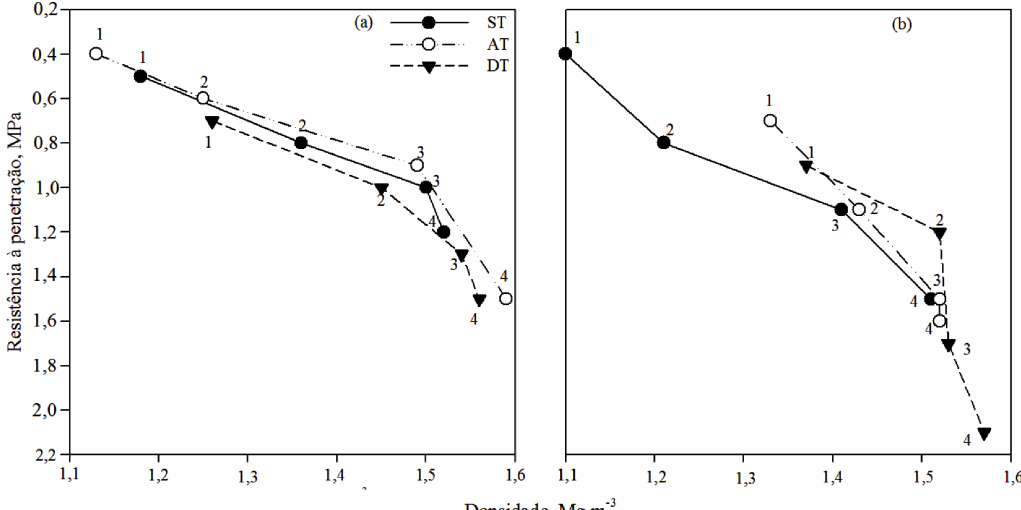
Figura 5. Resistência mecânica do solo à penetração e densidade no solo na condição de pousio (a) e aveia + ervilhaca (b). Números sobre os marcadores indicam camadas no solo 0,0-0,05 (1), 0,05-0,10 (2), 0,10-0,15 (3) e 0,15-0,20 m